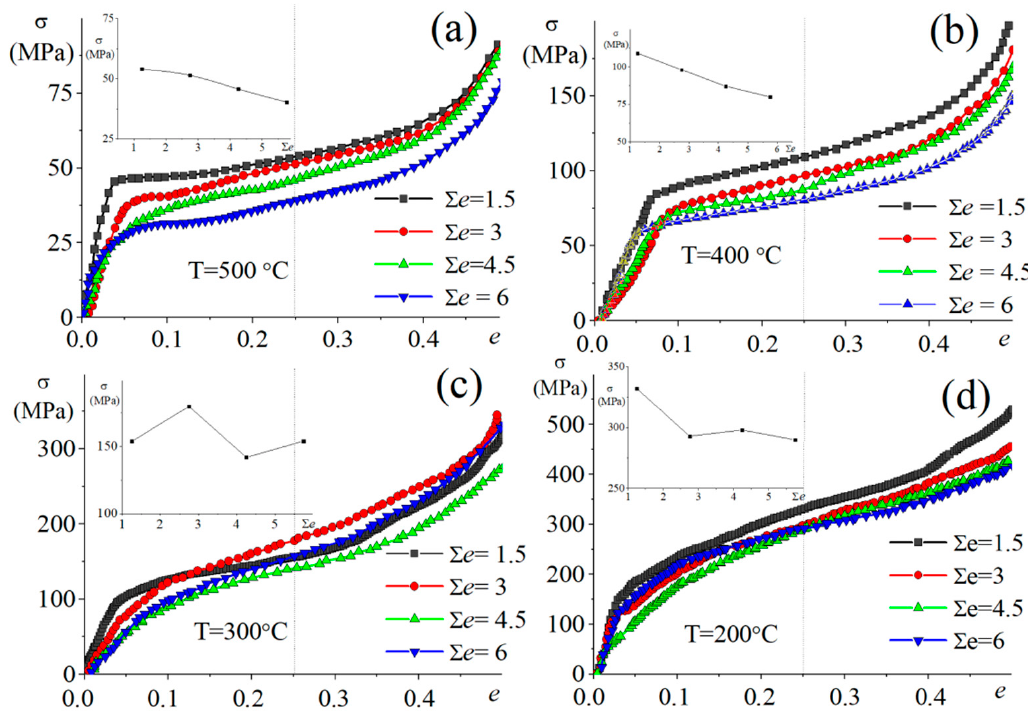
Figure 3. Stress–strain curves of 3, 6, 9, and 12 IMF passes at ( a ) 500 °C, ( b ) 400 °C, ( c ) 300 °C, and ( d ) 200 °C. The stress on the steady stage vs cumulative strain at each temperature is presented in the insets.